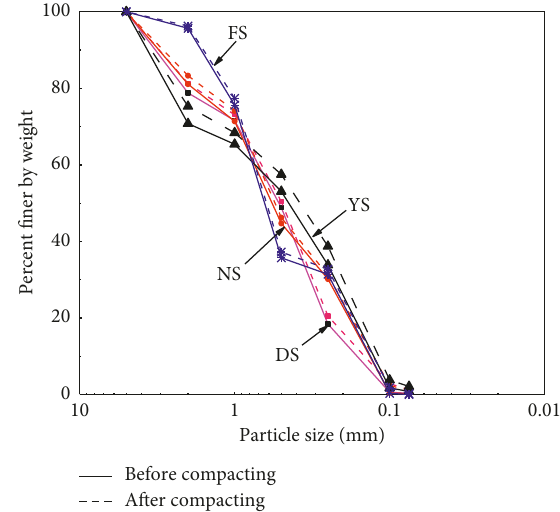
Figure 1: Particle size distribution curves of the test